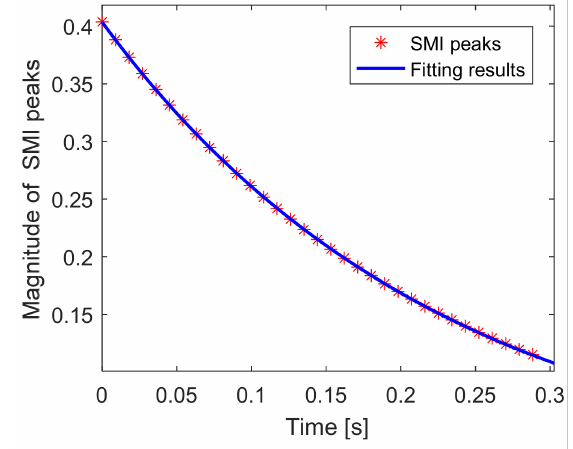
Figure 5. Curve fitting result of SMI signals without fringes.